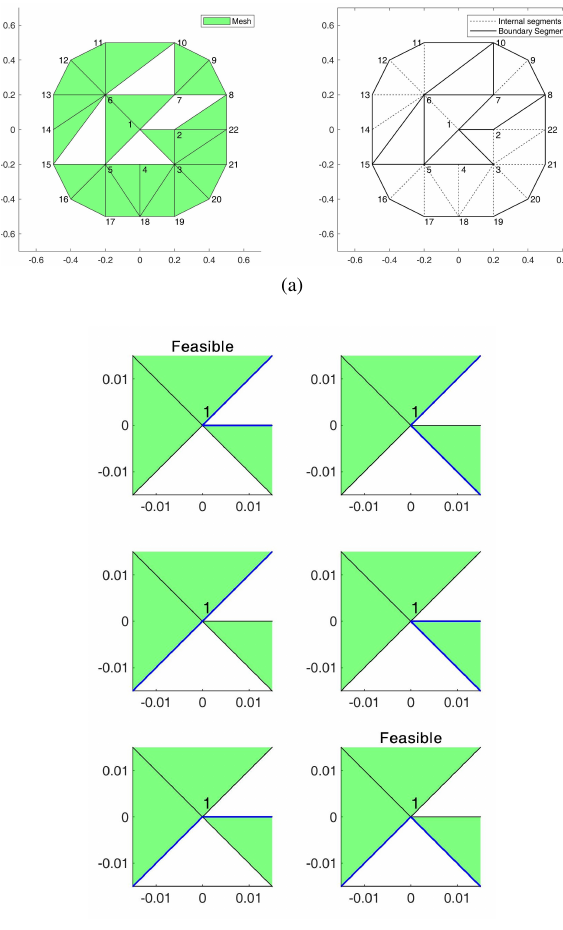
Figure 11: Example of the check procedure on the vertex number 1, which is an end-point for more than two boundary segments.